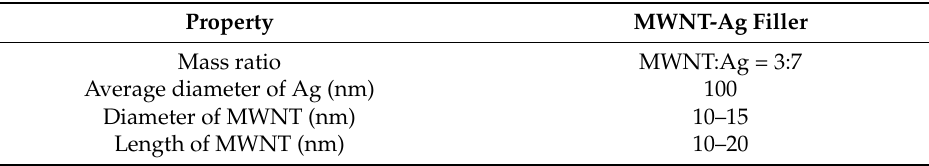
Table 1. Features of MWNT-Ag.